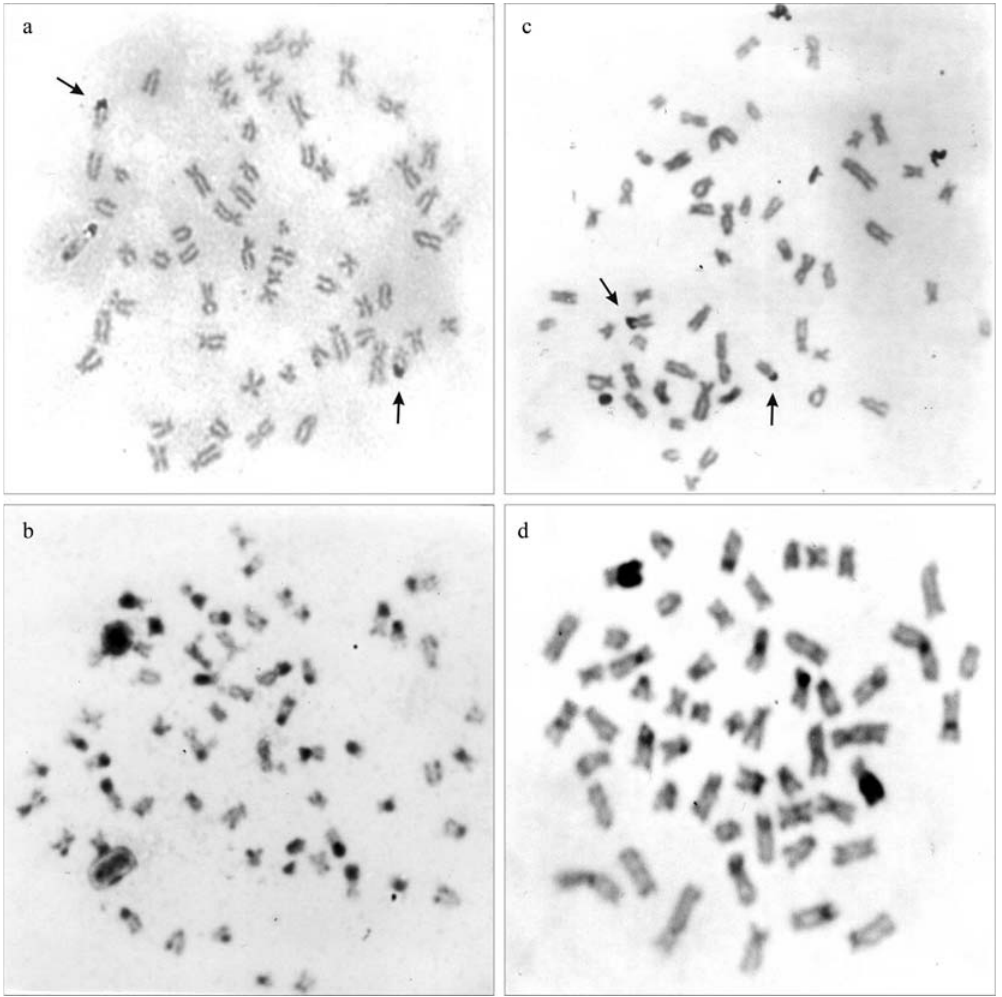
Figure 2 - Metaphases of Conorhynchus conirostris : (a) silver nitrate staining, and (b) C-banding; and metaphases of Lophiosilurus alexandri : (c) silver nitrate staining, and (d) C-banding. The Ag-NORs are indicated by arrows (a,